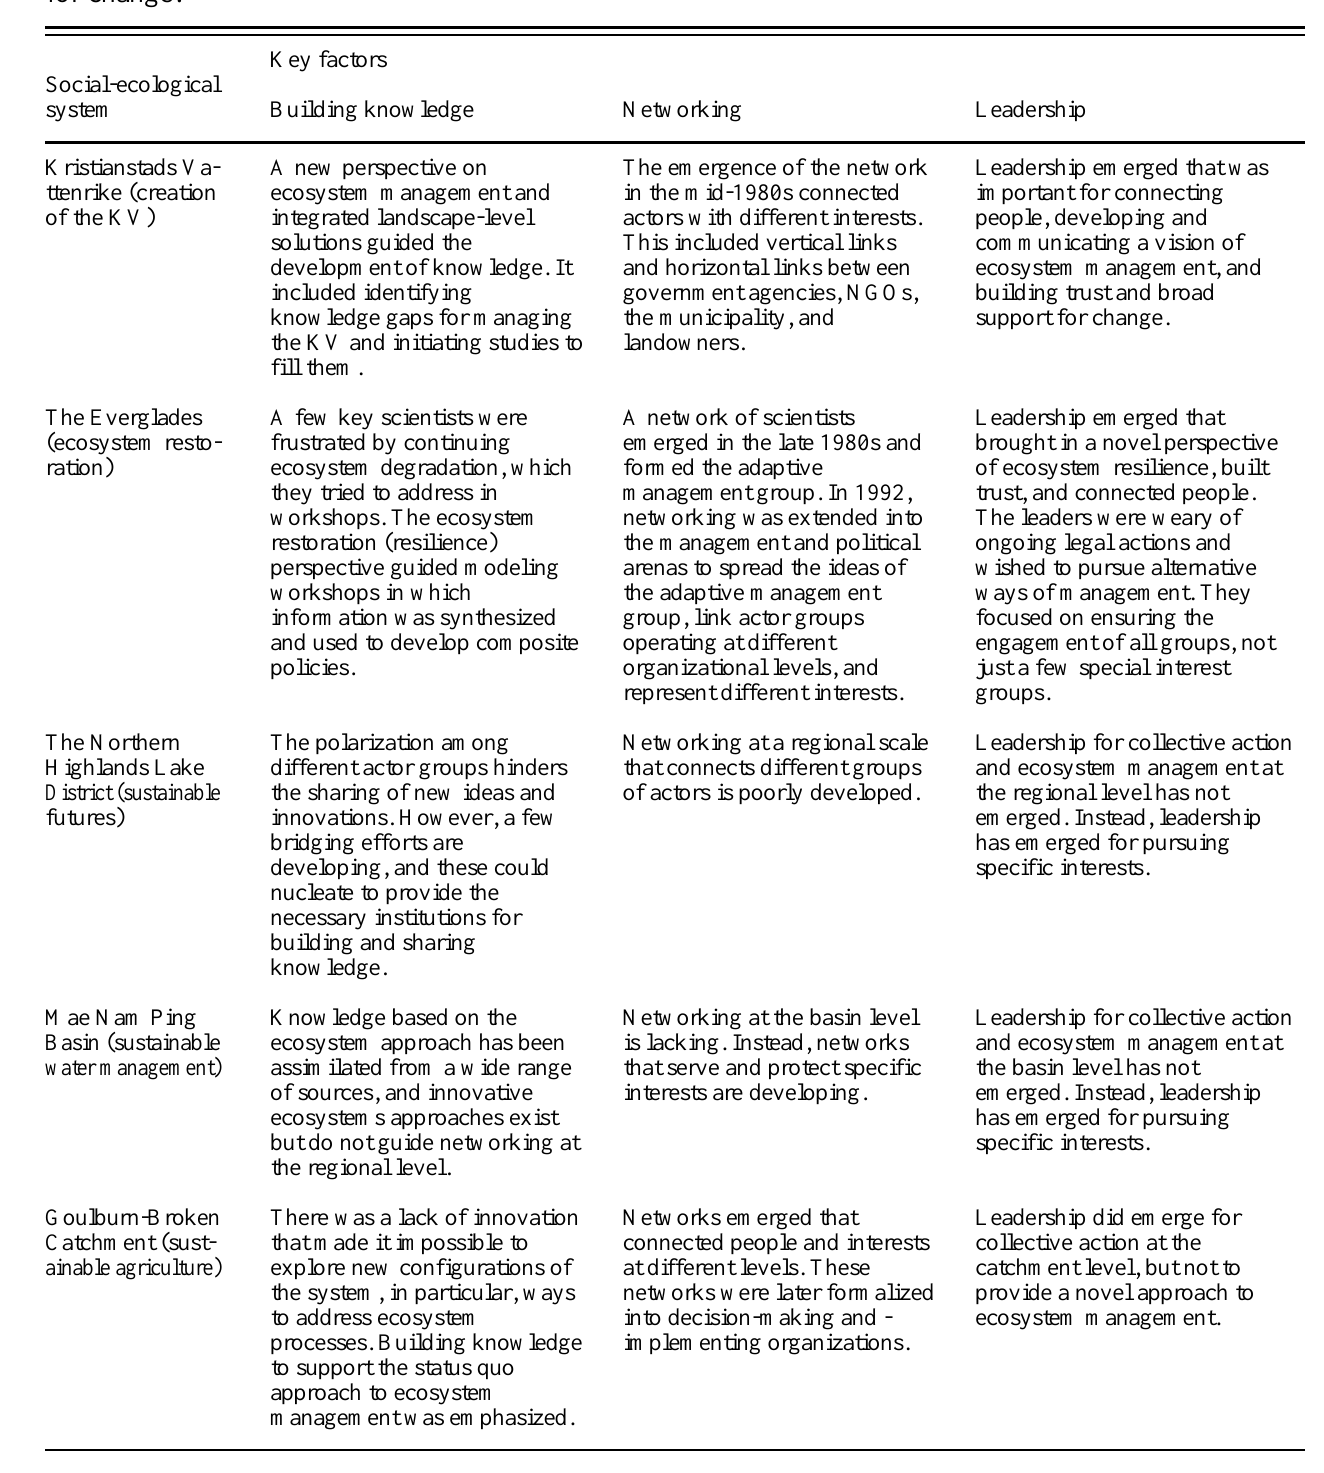
Table 1 . Comparing the five case studies regarding key factors for preparing the social-ecological system for